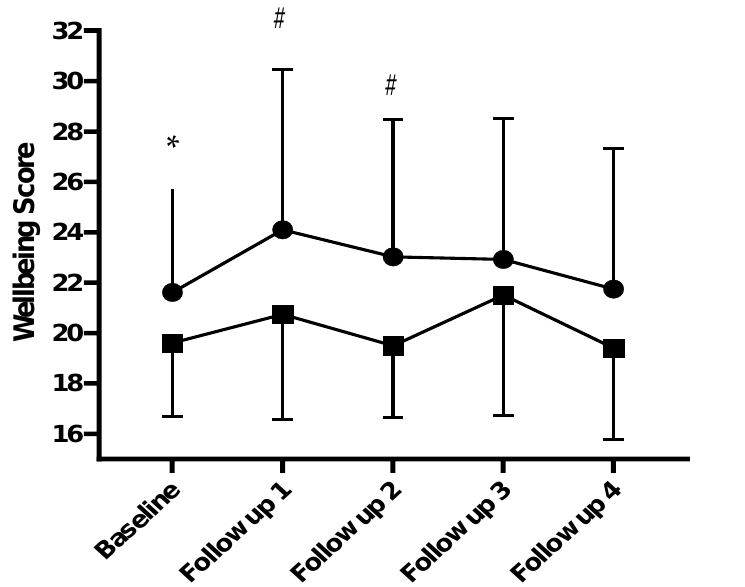
Figure 1. Mean ± SD of changes in wellbeing in male and female garden members (* indicates significantly lower score than UK population norm for males and females; # indicates significantly lower score than the UK population norm for females only). Note: follow up 1 is on average 0.86 years after baseline, follow up 2 1.70 years after follow up 1, follow up three 0.44 years after follow up 2 and follow up four 0.27 years after follow up 3.